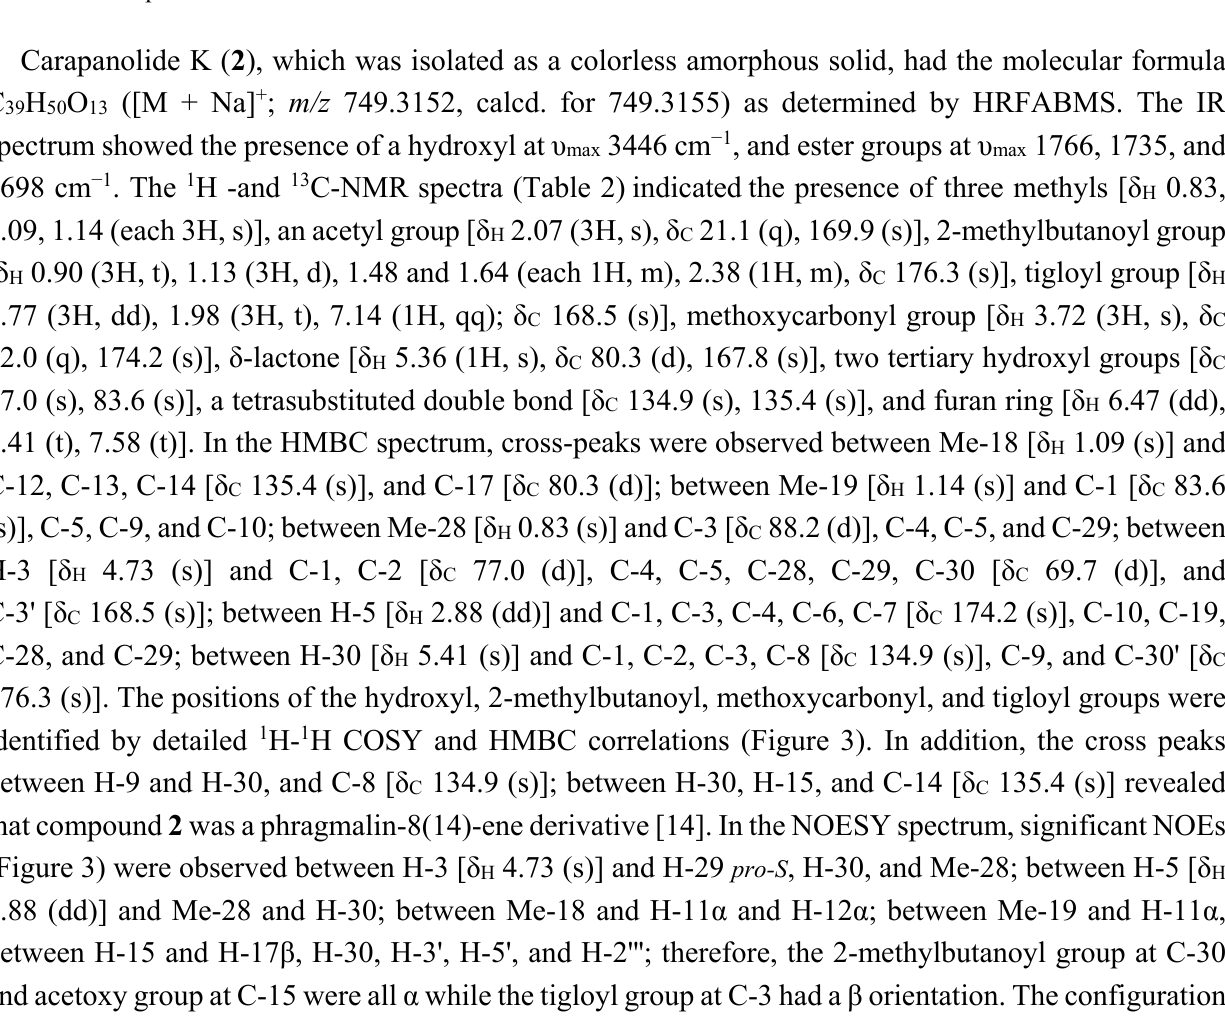
a Measured at 600 MHz in CDCl HMBC